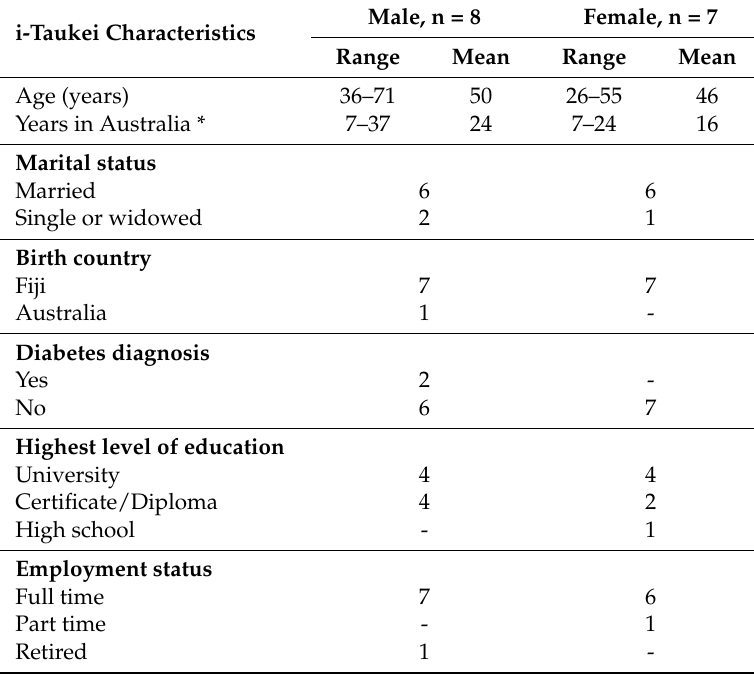
Table 1. Demographics of Adult i-Taukei Fijians interviewed (n =